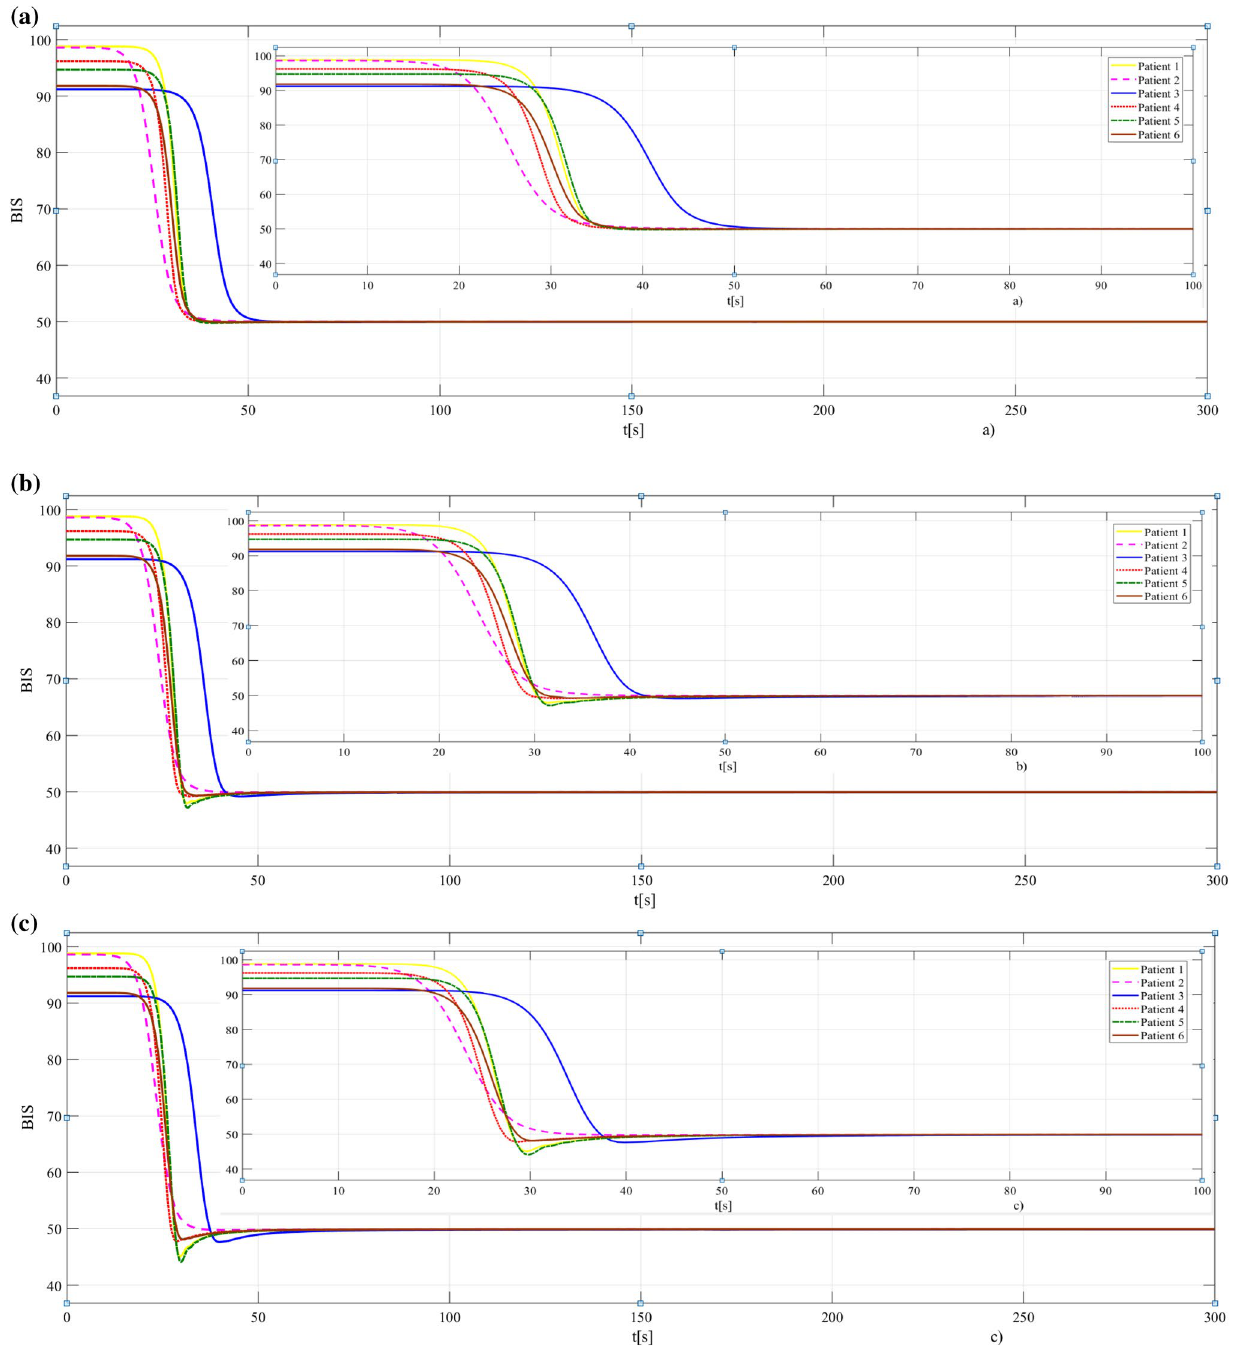
Fig. 6 BIS response for each patient (PI λ controller); a α = 0.5; b α = 0.75; c α =